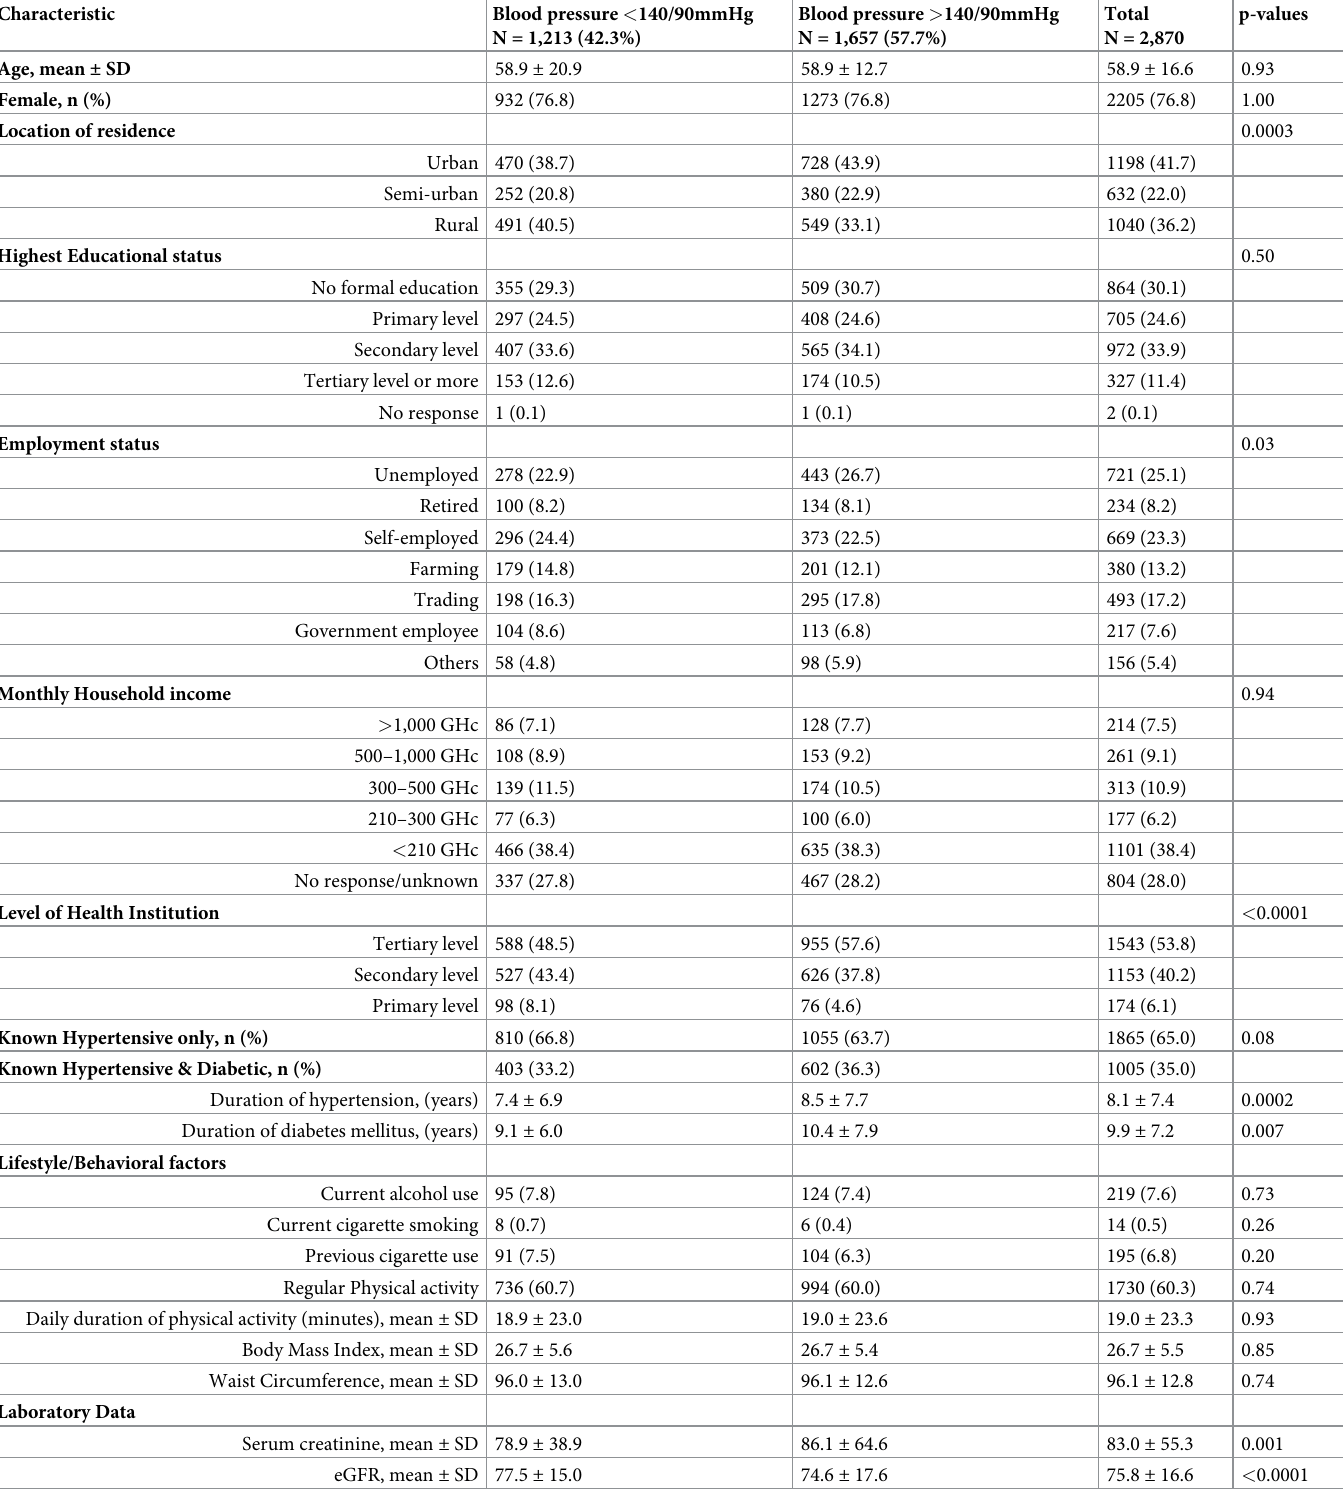
Table 1. Comparison of characteristics of study participants according to blood pressure control